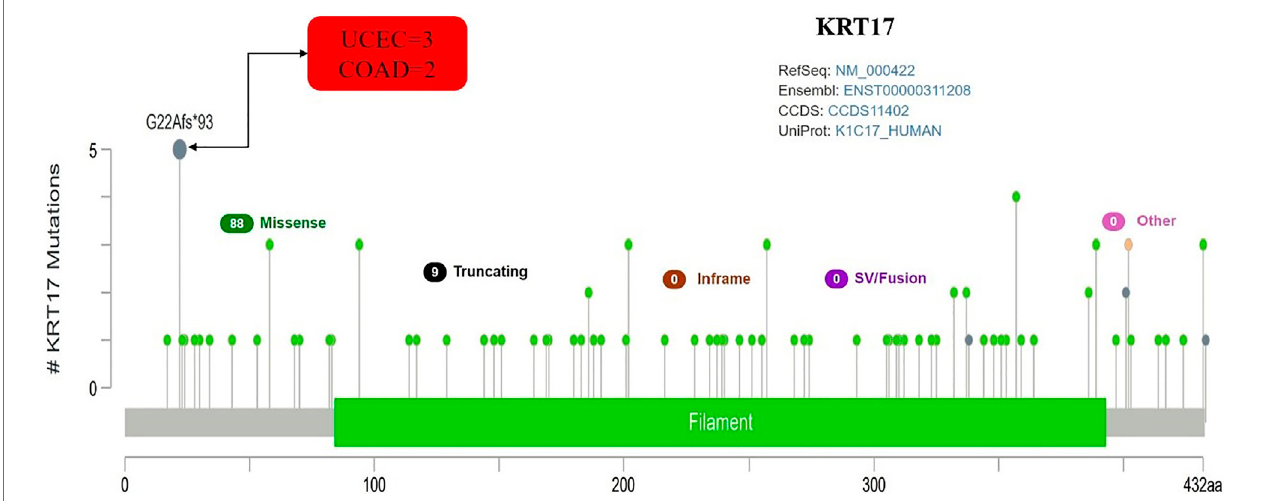
FIGURE 6 | Mutation site and number of cases of KRT17. G22Afs p 93 was the site with the highest mutation frequency. There were three cases in UCEC and two cases in COAD (TCGA